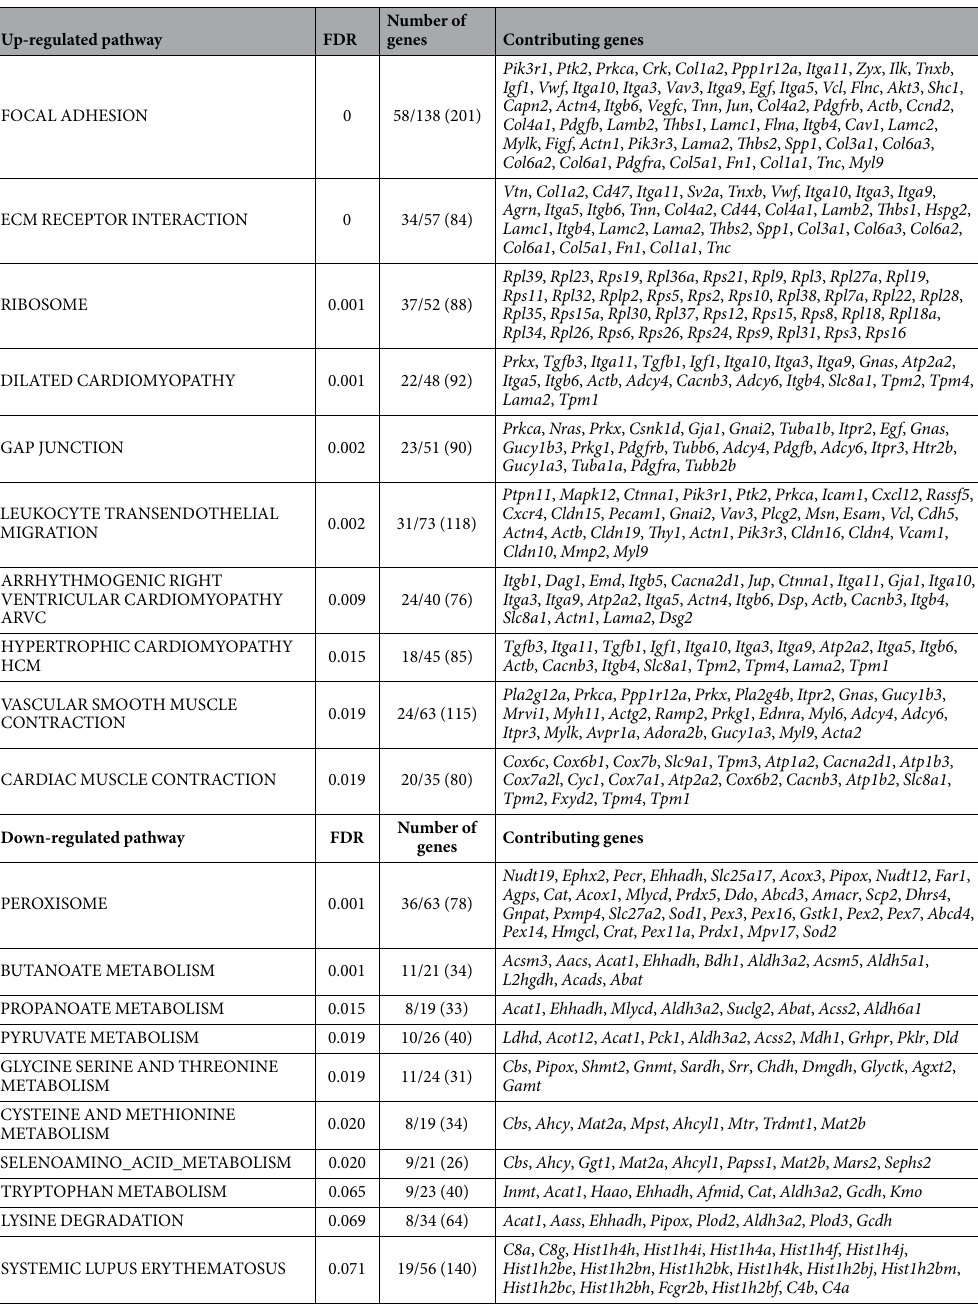
Table 4. List of the top 10 KEGG pathways up- and down-regulated in 1 month-old male Tg Umod C147W mice relative to age- and sex-matched Tg Umod wt . FDR, False Discovery Rate. Number of genes, A/B (C): A, number of genes contributing to pathway enrichment; B, number of genes from the KEGG pathway expressed in analysed experimental groups; C, total number of genes listed in the KEGG